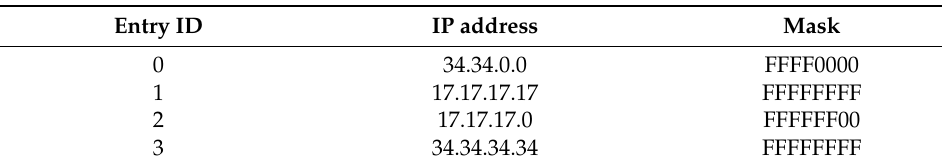
Table 4. Example of an LPM table.